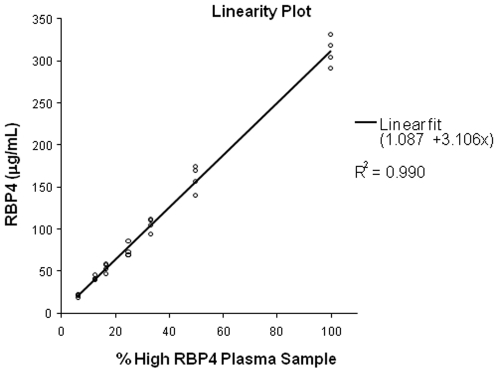
Are the plotted results of the quantitative MSIA linearity study.The regression analysis was only able to fit a first order polynomial (1.087+3.1016×; R2 = 0.990) to the data set. The absence of non-linearity describes the assay as possessing linear characteristics.